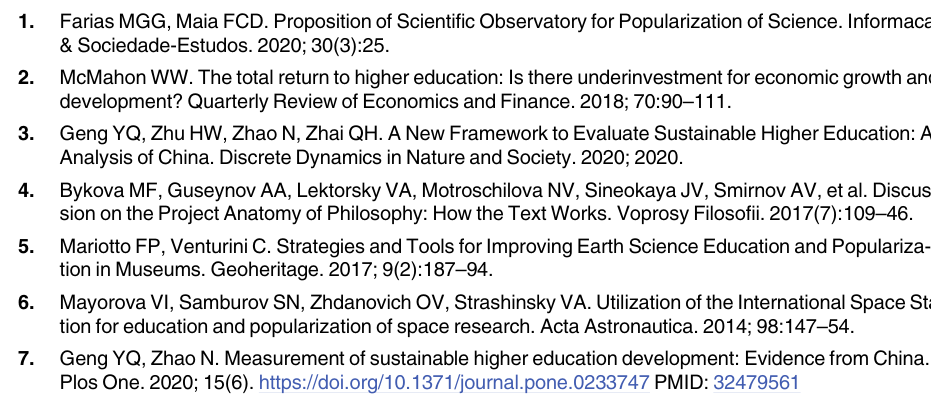
S1 Table. Overall performance of the higher education system. S2 Table. Overall performance of the science popularization system. S3 Table. Coordinated growth performance between two systems. S4 Table. Predictions of the coordinated growth